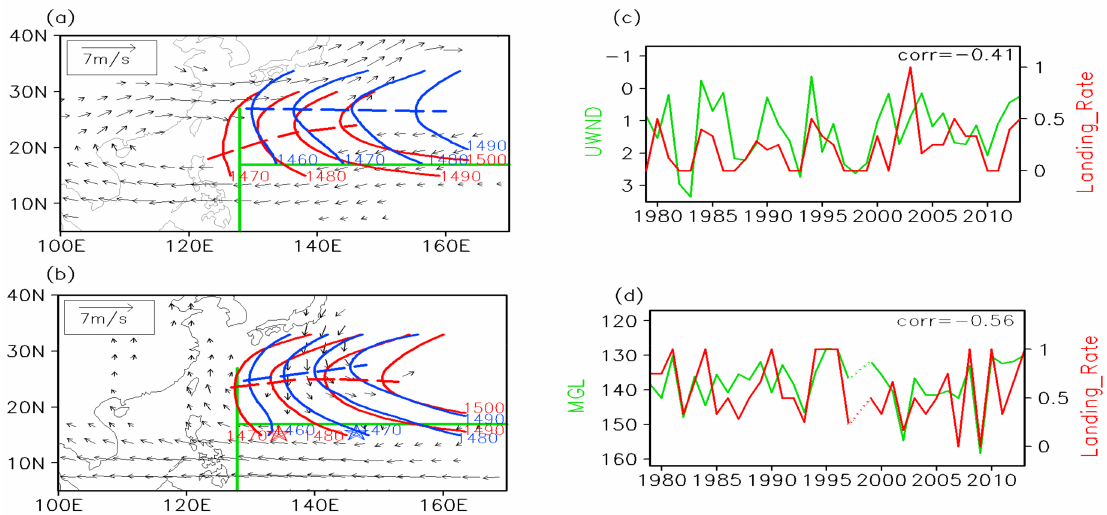
Figure 6. Maps of the differences in mean steering flows (vectors) between the positive and negative phases of PC1 ( a ) and PC2 ( b ), superposed with the climatological mean geopotential height at 850 hPa (contour) for the positive phase (red) and negative phase (blue). The dashed line indicates the ridge line of the subtropical high. The filled star in ( b ) represents the mean genesis location (red for positive and blue for negative). ( c ) The time series of area-averaged 850-hPa zonal wind (UWND; 20–30 ◦ N, 120–140 ◦ E) and TC landing rate in region II. ( d ) Time series of TC landing rate and mean TC genesis longitude in region III. The Landing_Rate in ( c , d ) are defined as landing TC numbers divided by total TC